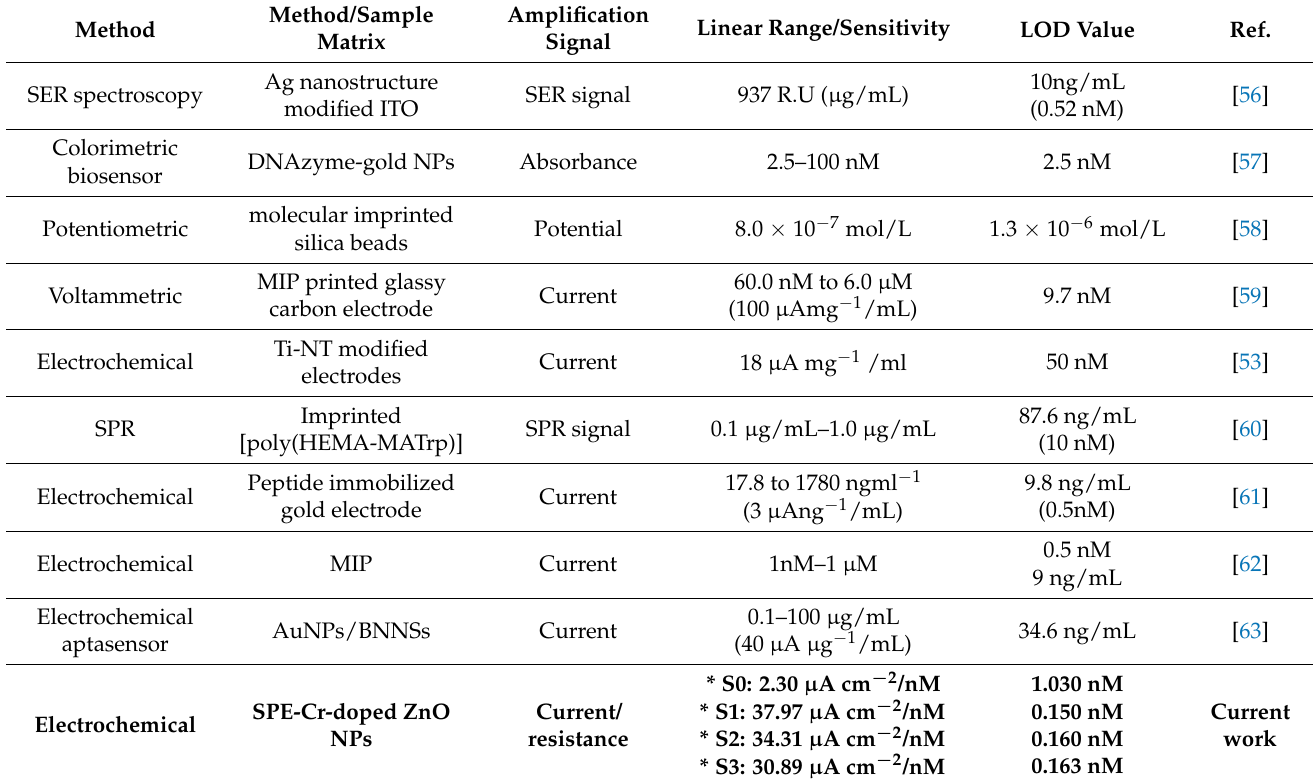
Table 2. Reported LOD values based on method of detection and